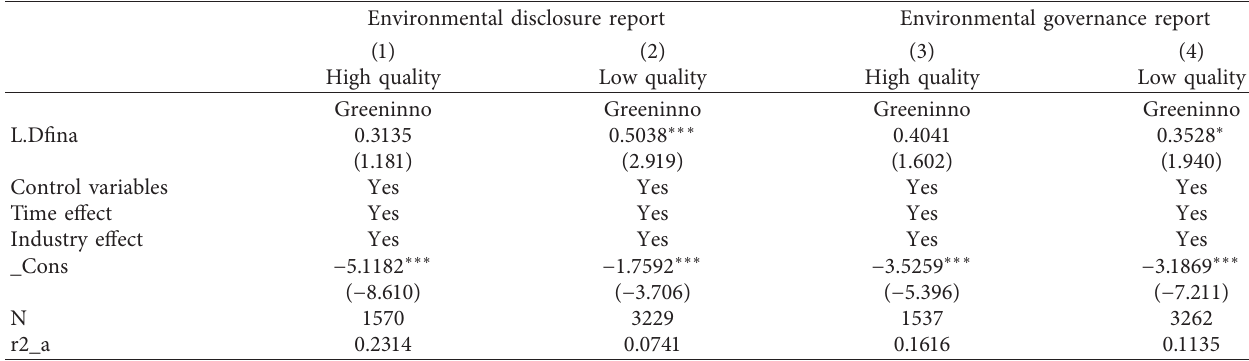
Table 5: Regression results of information quality